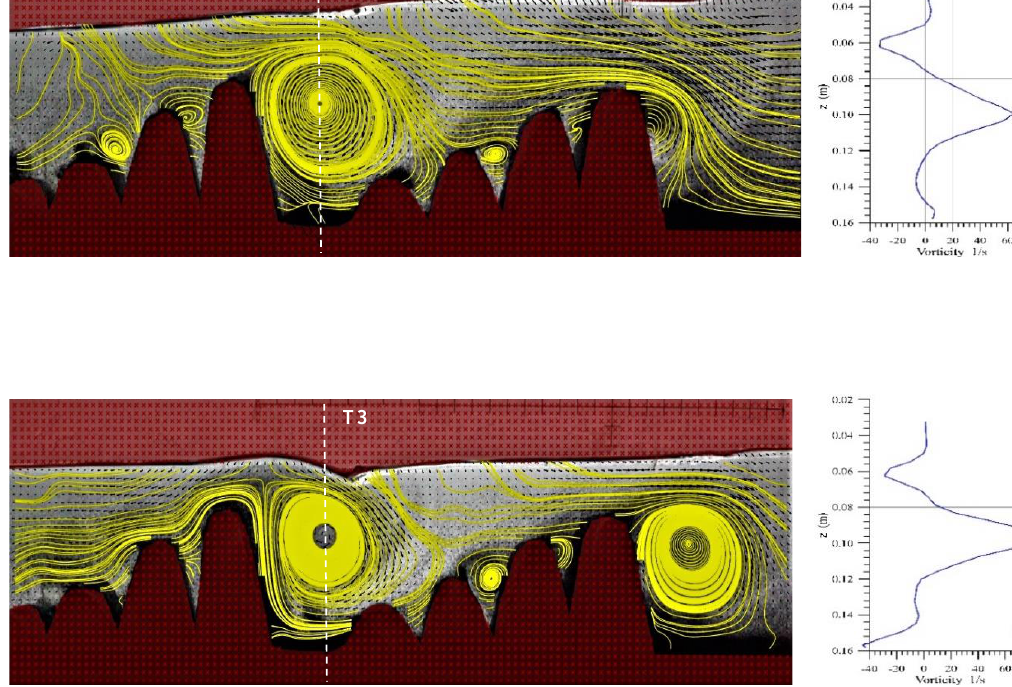
Figure 16. The temporal variation of streamlines and the vorticity distribution along the vertical line of the vortex center induced by a solitary-like wave propagating over a composite set of undulating submerged breakwaters.